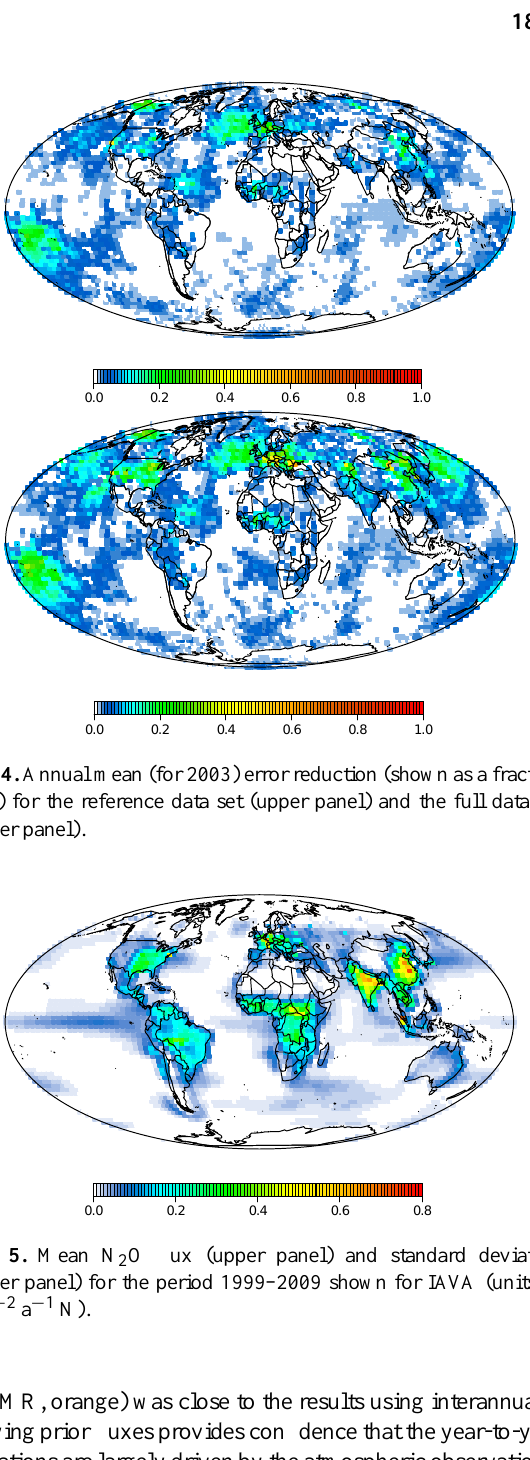
(CLMR, orange) was close to the results using interannually varying prior fluxes provides confidence that the year-to-year variations are largely driven by the atmospheric